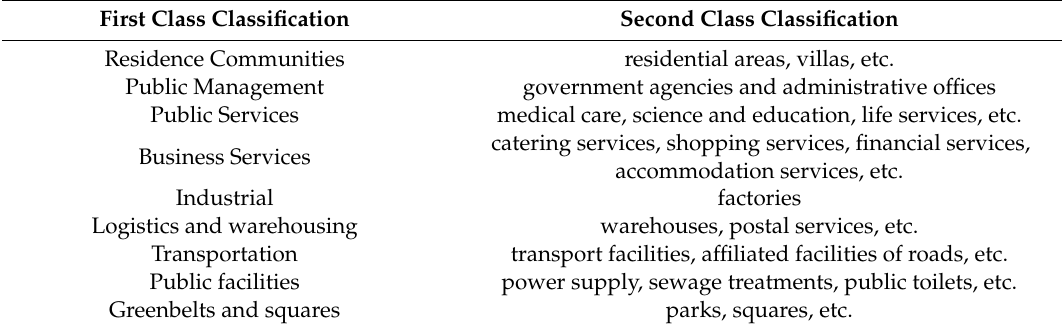
Table 3. Reclassification of Points of Interest